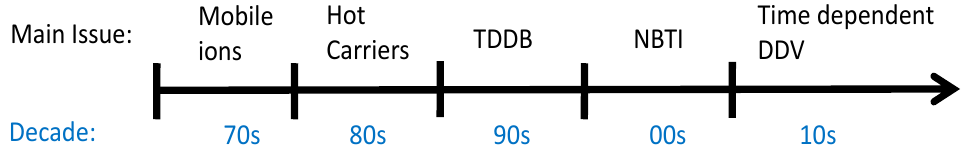
Figure 1. The main reliability issue in each decade for CMOS technologies. DDV: device-to-device variation.